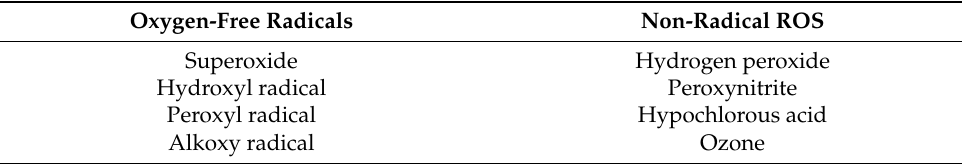
Table 1. Most common ROS divided into oxygen-free radicals and non-radical